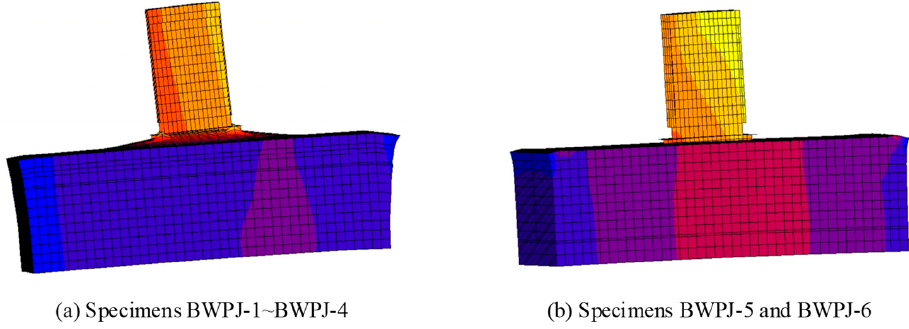
Figure 14. Two characteristic deformation patterns (Deformation scaling factor = 15).